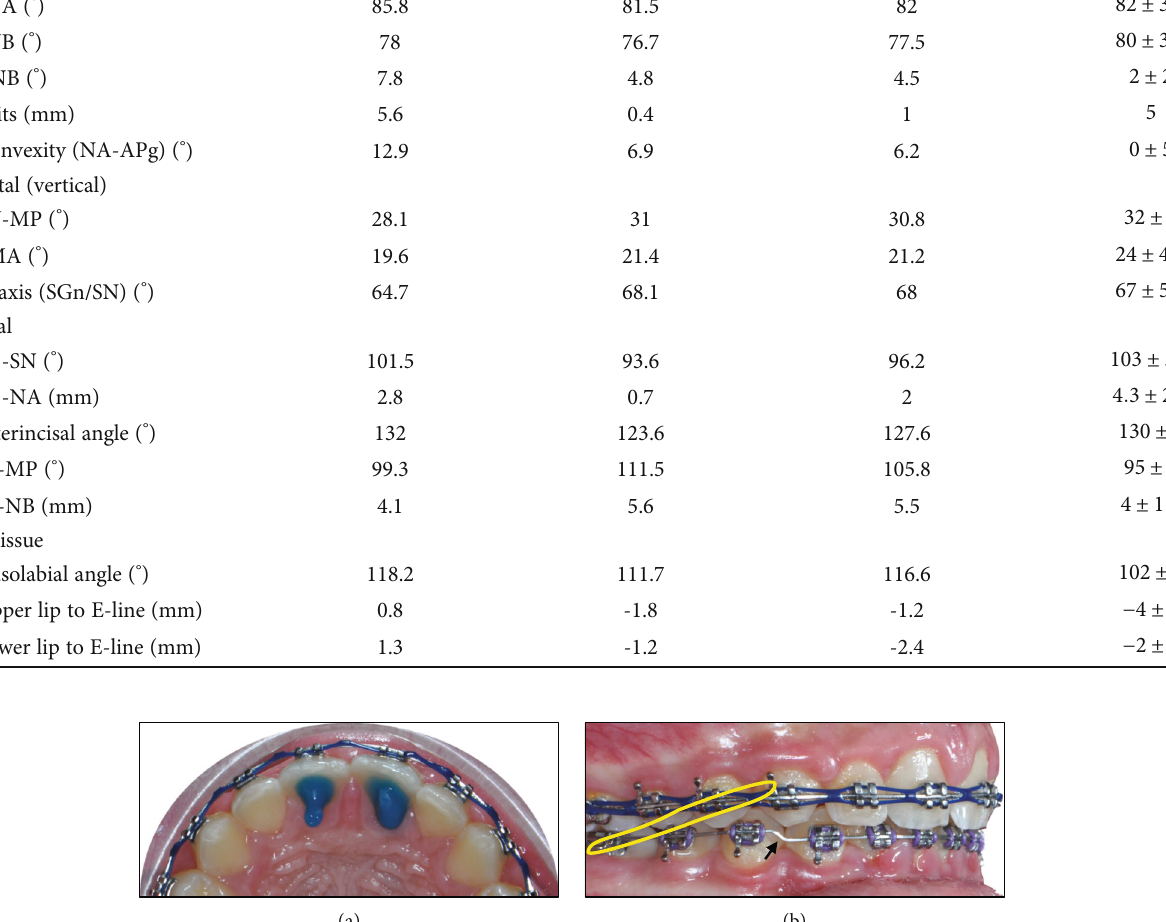
Figure 4: (a) Anterior bite turbo cemented on palatal of maxillary central incisors. (b) The use of reverse COS in the lower arch wire, step down bends (black arrow) for lower anterior teeth, and Class II elastic bands (yellow imaginary